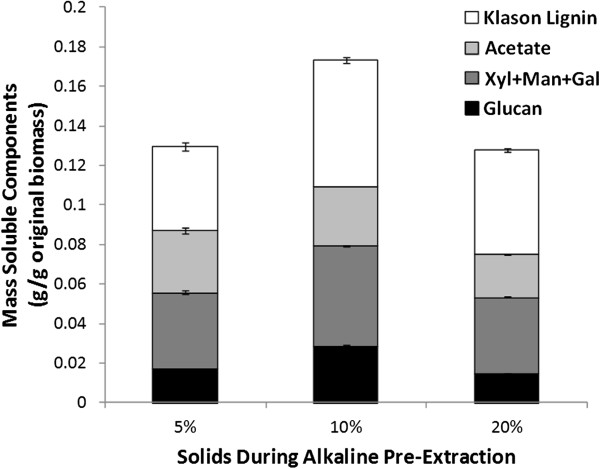
Content of lignin, acetate, and total polymeric and oligomeric neutral polysaccharides in alkaline pre-extraction liquors as a function of solids loading during alkaline pre-extraction. Pre-extraction was performed at 0.08 g NaOH per g corn stover, at 80°C for 1 h and results show a maximum extraction of cell wall biopolymers at 10% (w/v) solids, which is likely a consequence of imperfect alkali penetration into the biomass at 20% (w/v) solids because of the limitations of the laboratory-scale mixing.